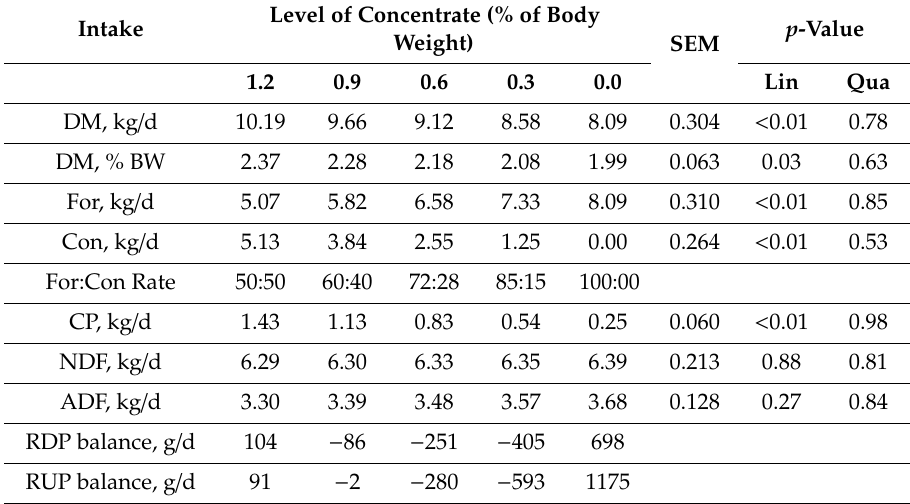
Table 1. Dry matter (DM), forage (For), concentrate (Con), and nutrient intake of Pantaneira cow breed, fed with di ff erent levels of concentrate.